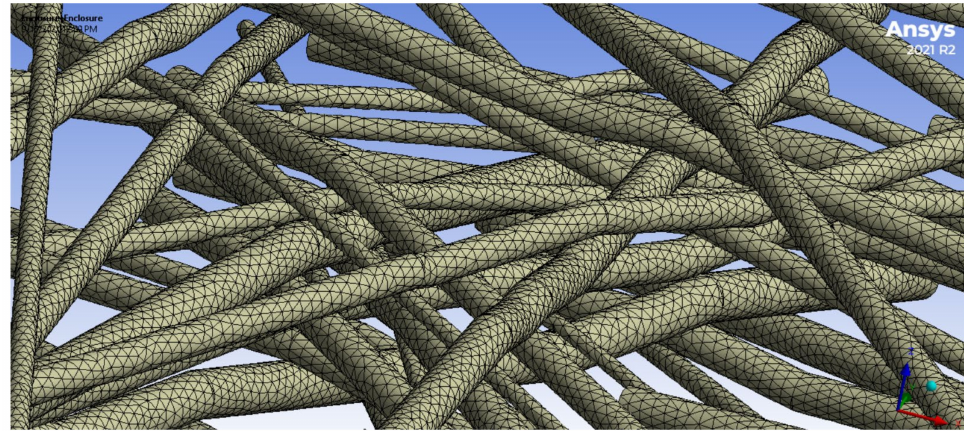
Figure 6. Non-intersecting fibers meshed with Ansys Mechanical.